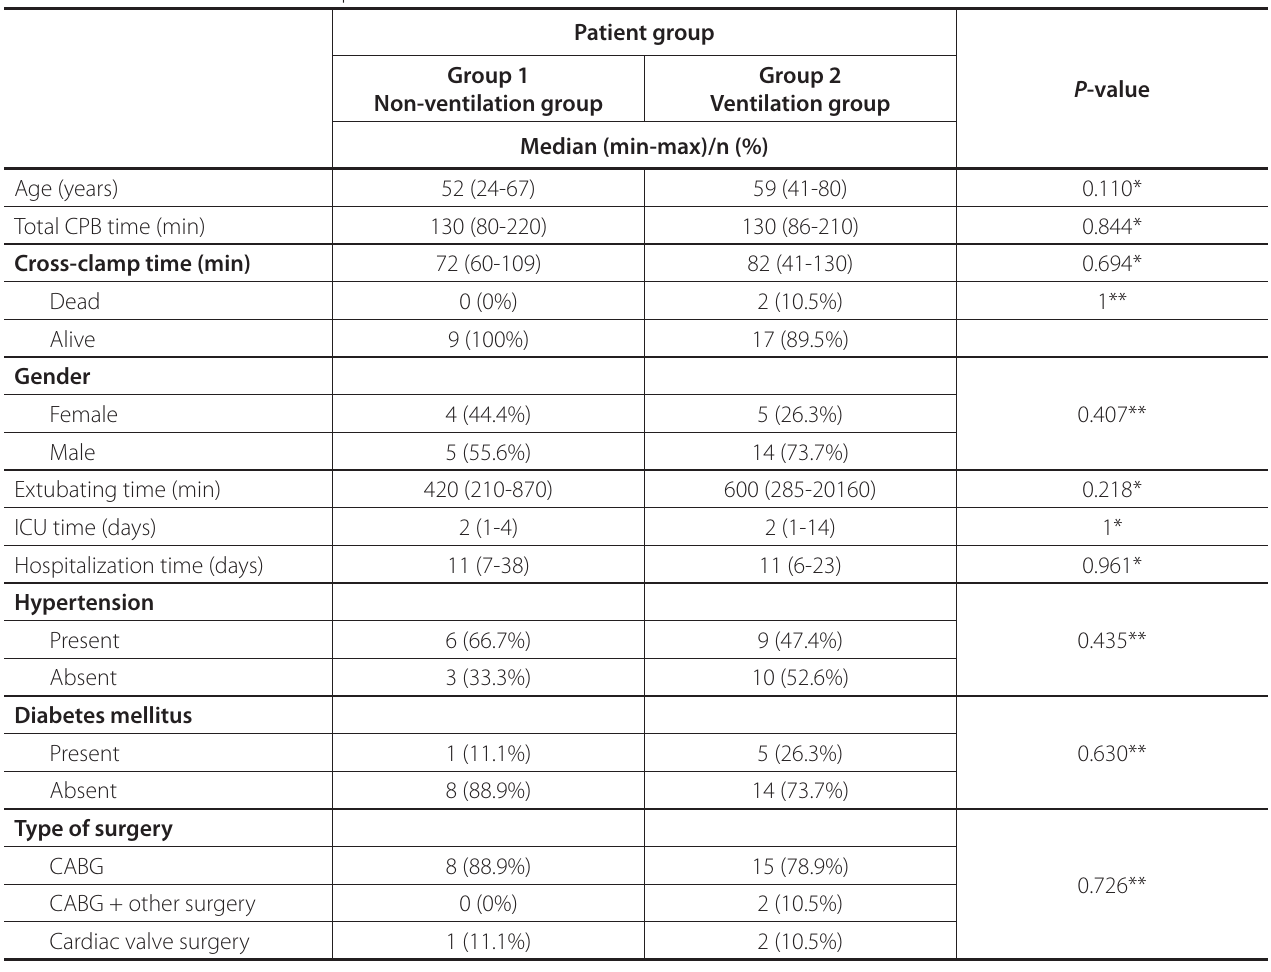
Table 1 . General characteristics of